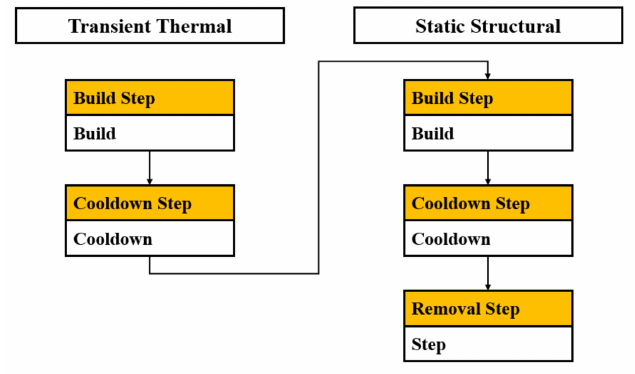
Figure 5. Flow chart of Ansys additive